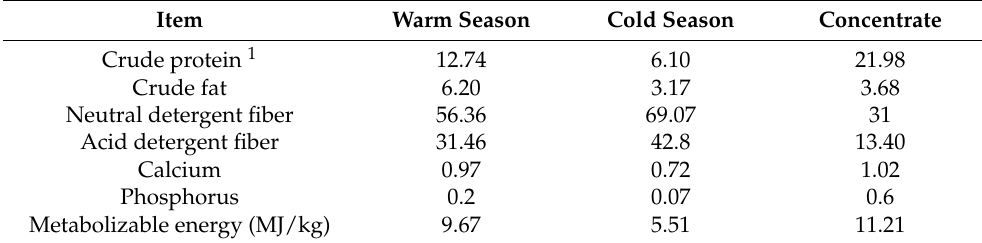
Table 2. Chemical compositions of the forage grass and concentrate (dry matter basis